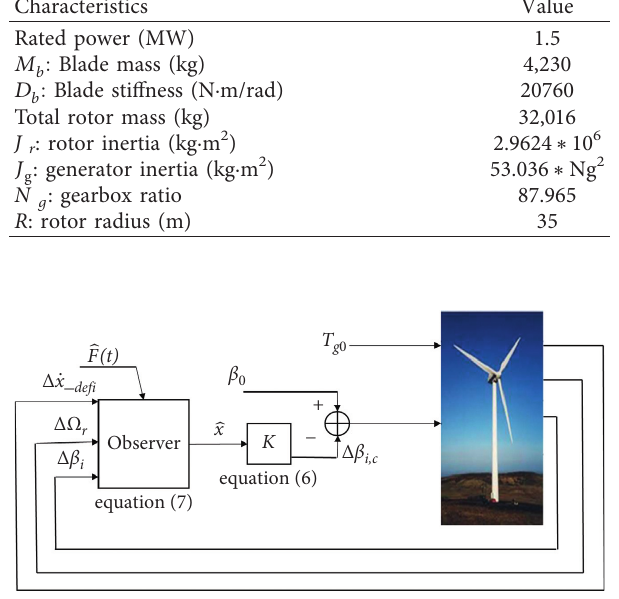
Figure 3: The wind turbine control objective